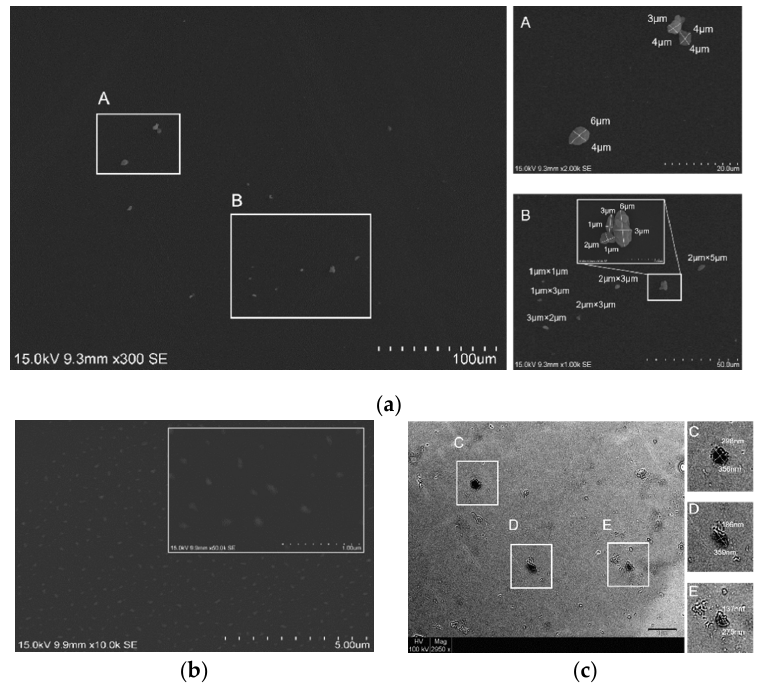
Figure 1. ( a ) SEM image (300×) of ASL micelles. Inset A and B show the magnified images (1k× & 2k×) of ASL micelles with size measurements by Image J. The inset in B showed a magnified image (10k×) of an ASL micelle. ( b ) SEM image (10k×) of TC–ASL micelles. The inset showed a magnified image (50k×) of TC–ASL micelles. ( c ) TEM image (2950×) of TC–ASL micelles. Inset C, D, and E show the magnified images of TC–ASL micelles with size measurements by Image J.